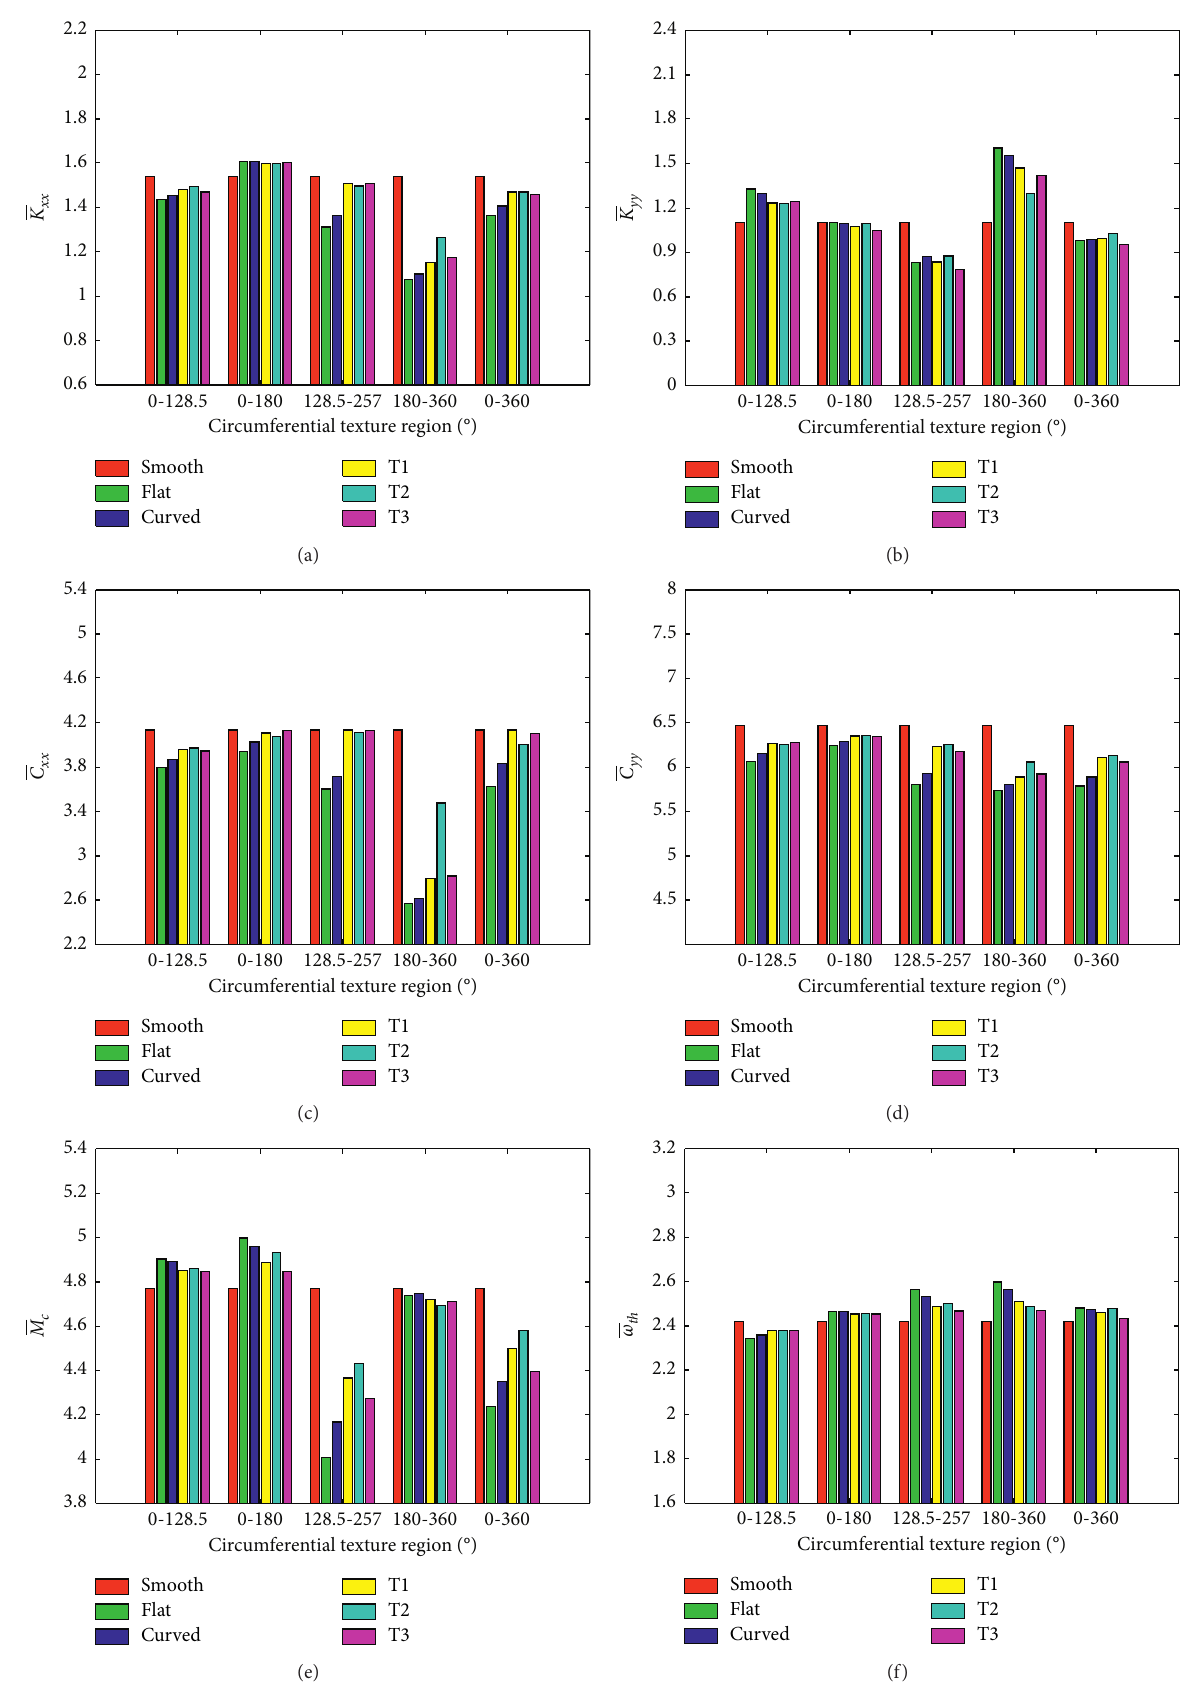
Figure 6: Effect of the circumferential texture region on dynamic and stability performance characteristics for smooth/textured journal ); (b) the direct stiffness coefficient ( K bearings: (a) the direct stiffness coefficient ( K xx direct damping coefficient ( C ); (e) the critical mass ( M c ); (f) the threshold speed of stability ( ϖ yy